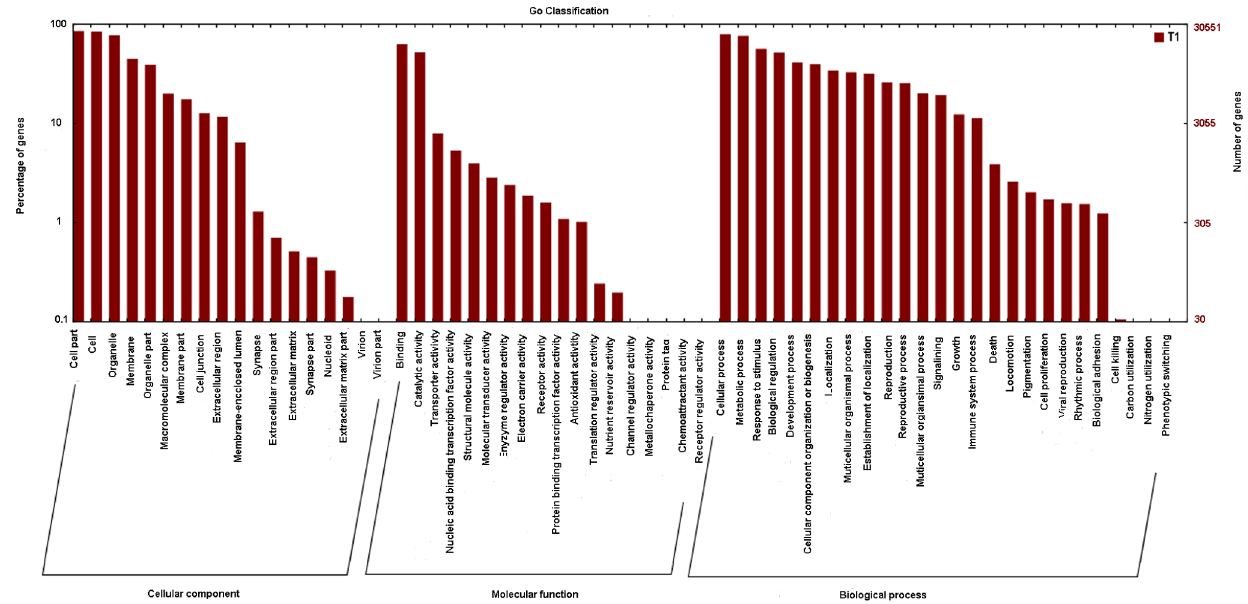
Figure 2. Functional annotation of assembled sequences based on gene ontology (GO) categorization. doi:10.1371/journal.pone.0090636.g002 PLOS ONE |